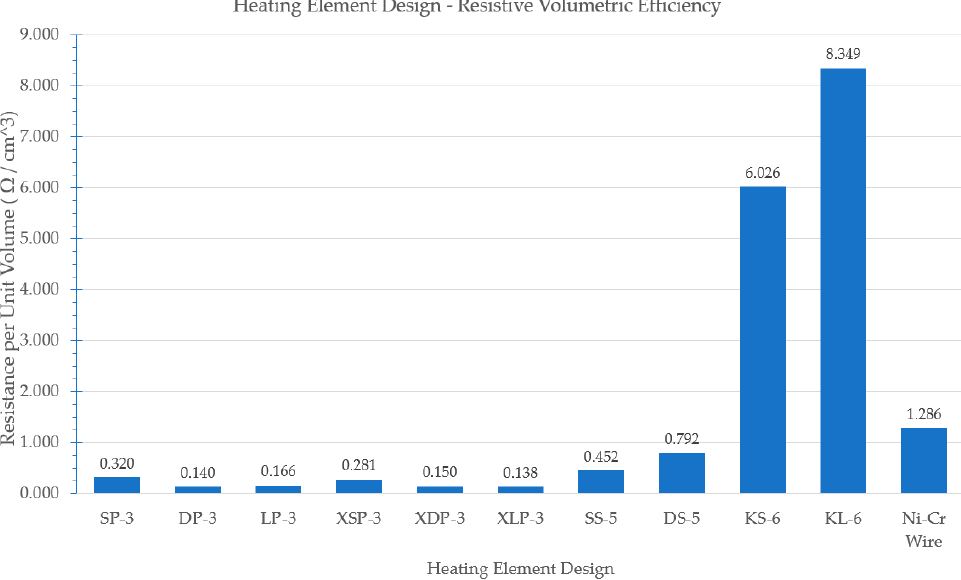
Figure A3. Linear regression resistance modeling. Linear regression models created based on electrical resistance data from resistive track measurements for LP-3, DP-3, and SP-3 heating designs.